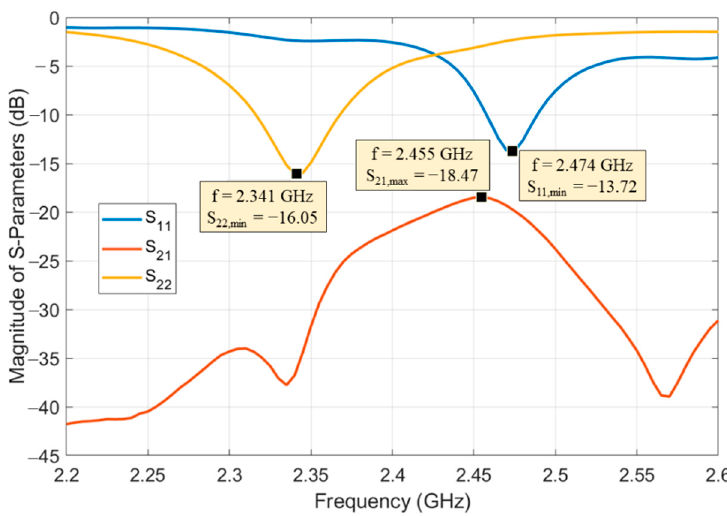
Figure 5. Measured results of the scattering parameters of the two-port antenna on board of the wireless sensor node: ports 1 and 2 are shown in Figures 3a and 4c and correspond to the patch and the metal-mounted chip antennas, respectively.